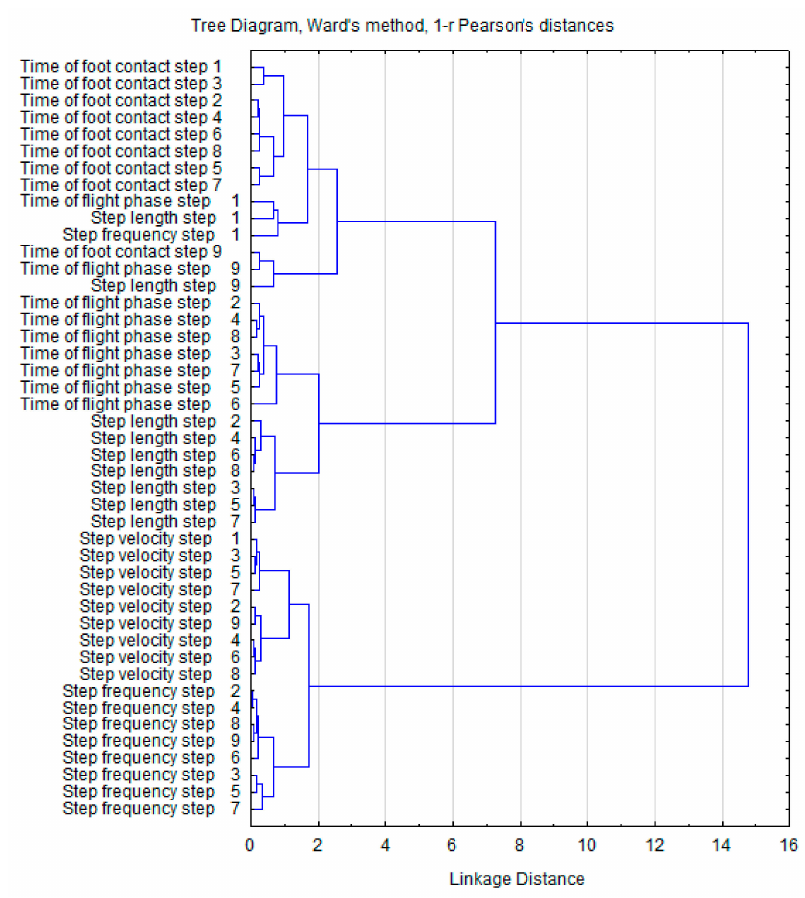
Figure 3. Dendrogram clustering of post-test sprint step